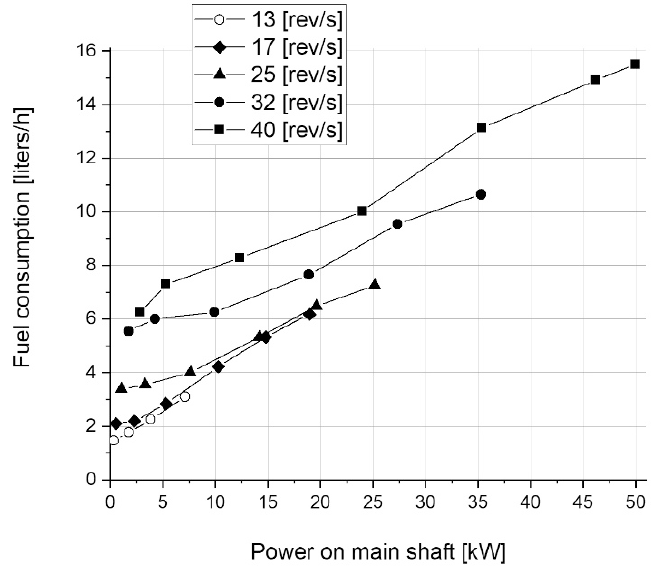
Figure 7. Measured fuel consumption as a function of rotational speed and power received from the main shaft during operation of the propulsion in the internal combustion engine operation mode.